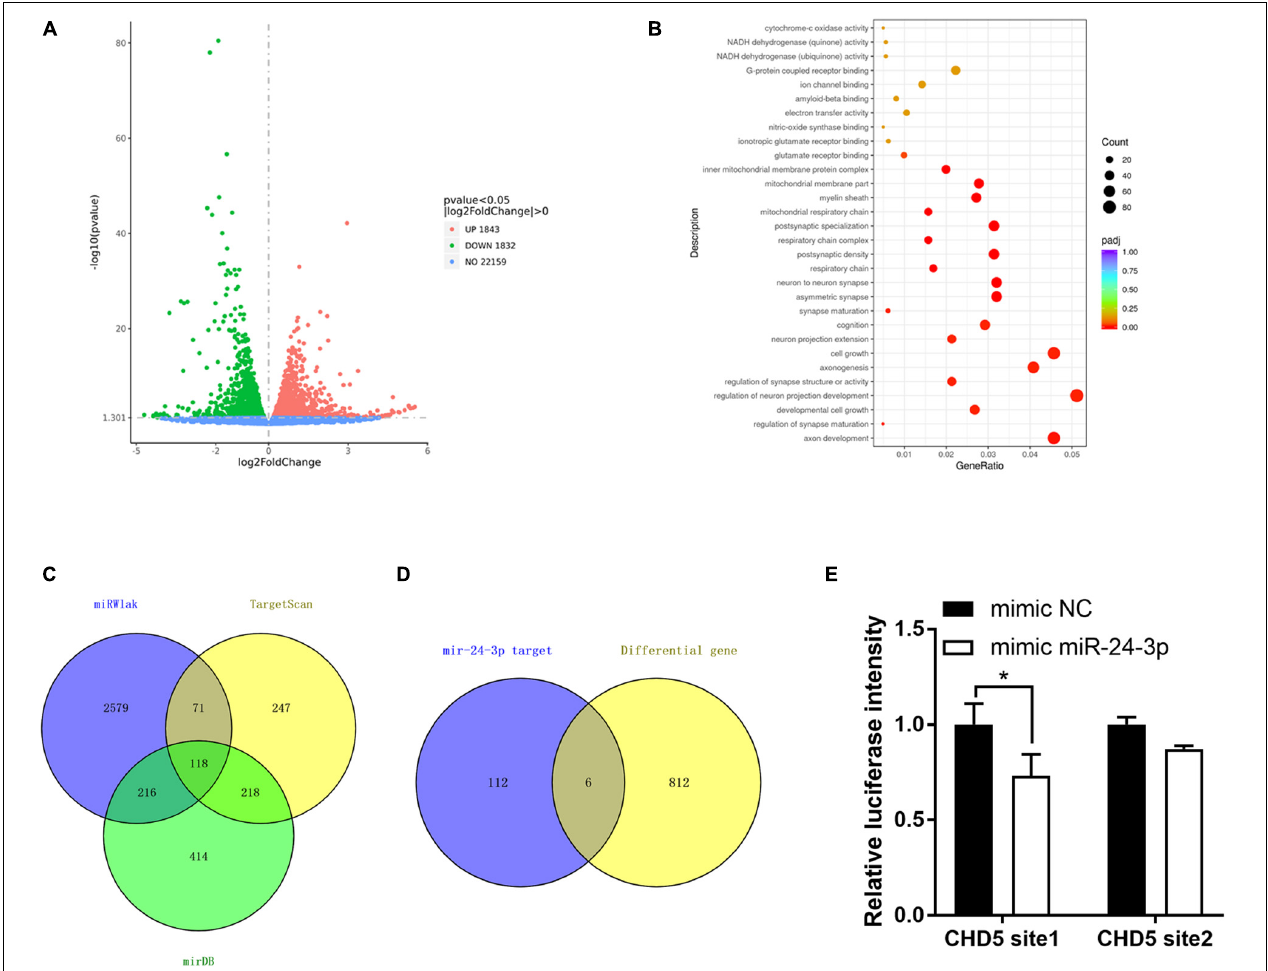
FIGURE 7 | CHD5 is the target gene of miR-24-3p. (A) The variation of genes expression in N2a cells transfected si-circRtn4 were revealed in the scatter plot. (B) Gene Ontology analyses of downregulated genes. (C) The Venn diagram showed the potential target genes predicted by databases. (D) The Venn diagram showed the same genes between genes predicted by databases and differential genes in transcriptome sequencing. (E) HEK-293T cells were cotransfected with psiCHECK TM -2-CHD5 site1, psiCHECK TM -2-CHD5 site2 or psiCHECK TM -2-control and miRNA mimics or miRNA negative control. Luciferase activity was detected with luciferase reporter assays. The results were shown as the mean ± SD (* p <